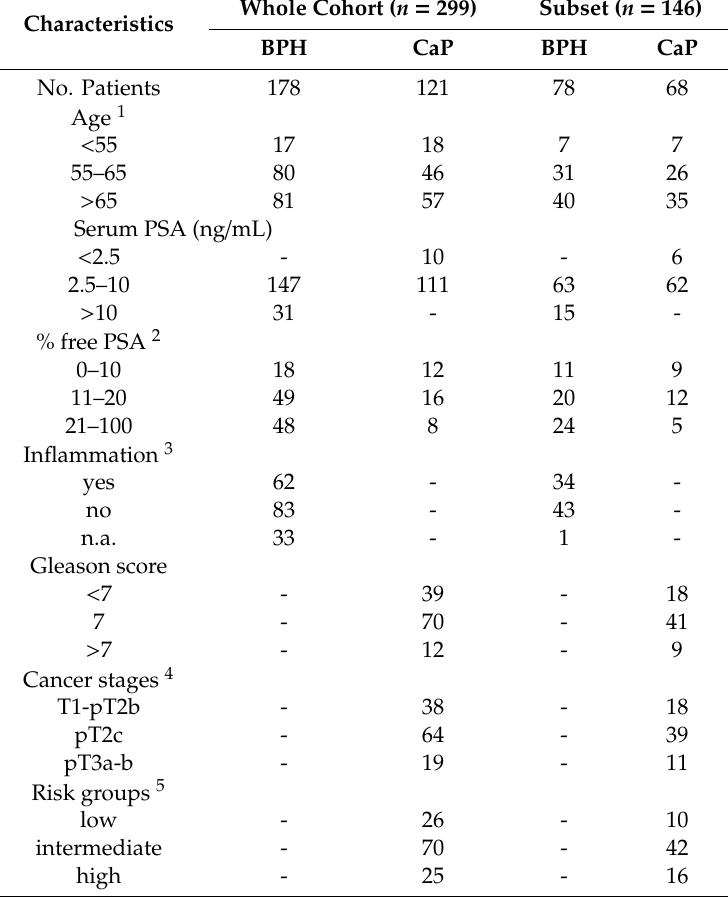
Table 1. Patients